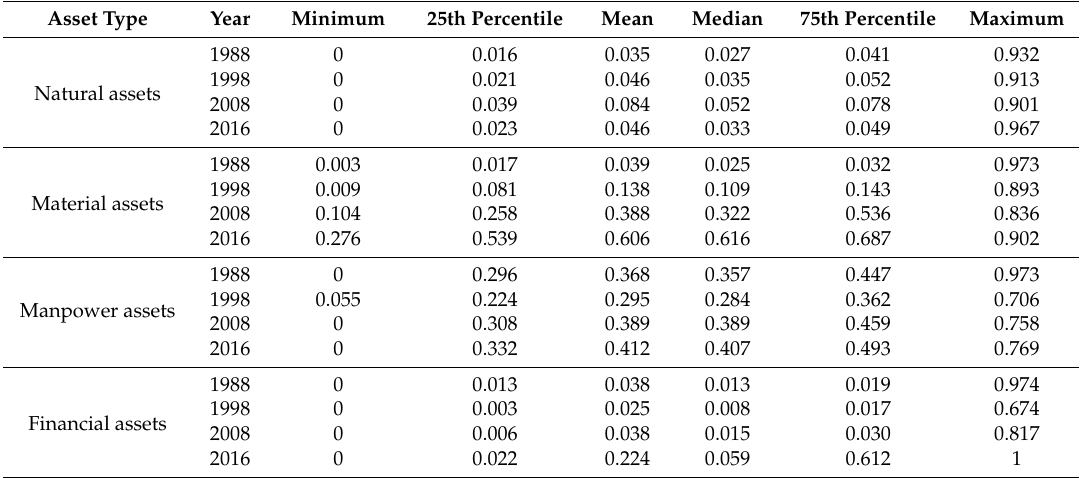
Table 3. The livelihood asset values of households in Sihe village in 1988, 1998, 2008, and